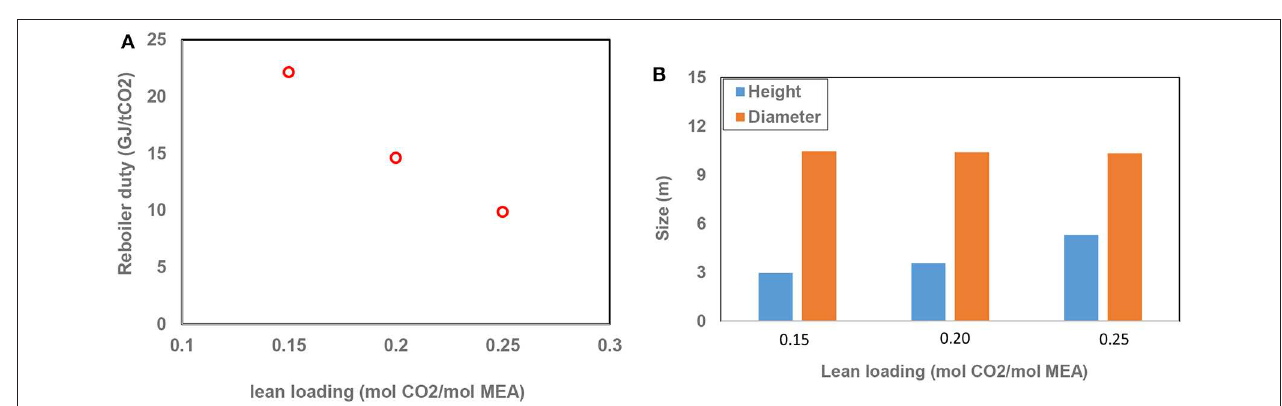
FIGURE 2 | The variation of (A) reboiler duty and (B) the height and diameter of the absorber with capture rate.